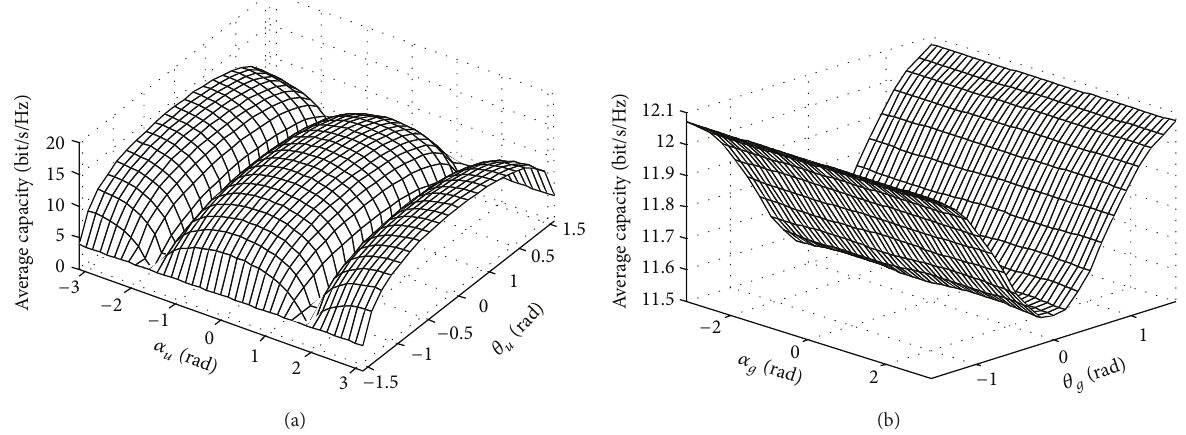
Figure 5: Influence of the position of antenna on the average channel capacity. (a) Transmitting antenna; (b) receiving antenna.